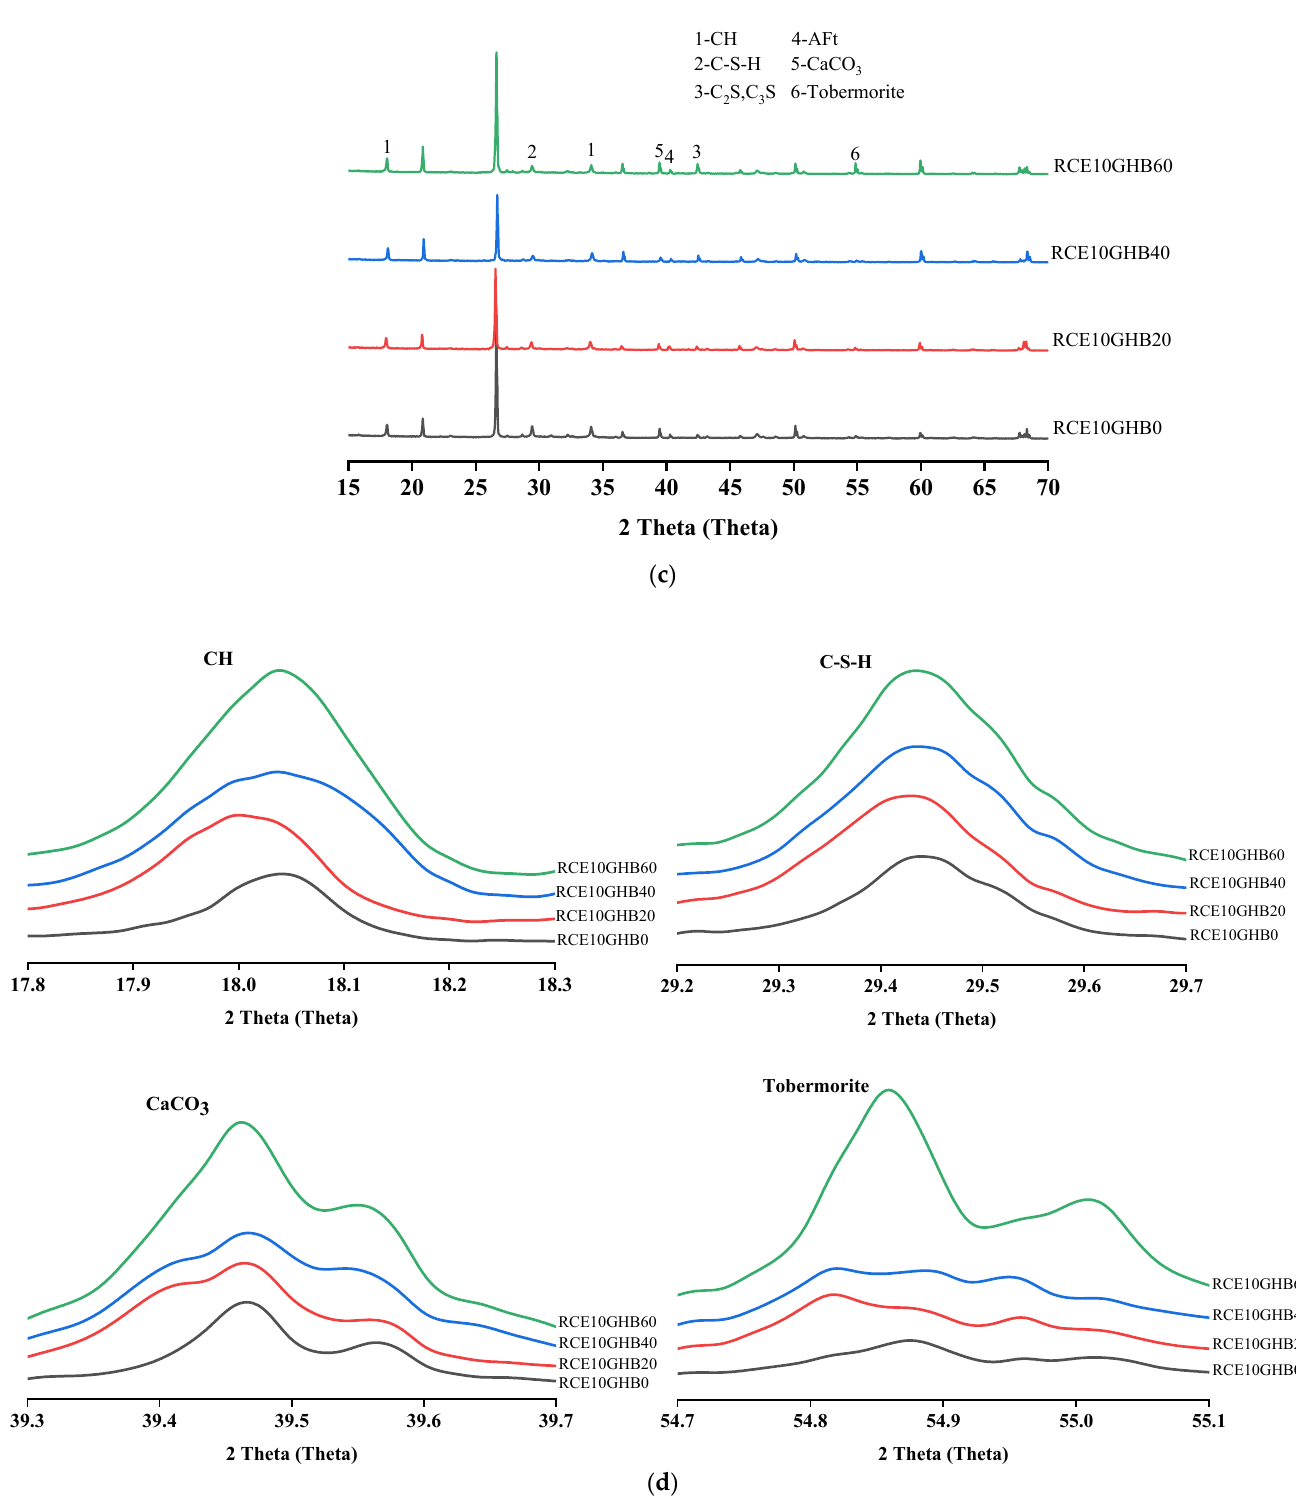
Figure 12. The experimental results of the crystal composition and hydration products of RTIC based on XRD. ( a ) The crystal composition and hydration products of RTIC (RCE0GHB0, RCE10GHB0, RCE20GHB0, RCE30GHB0); ( b ) CH, C-S-H, CaCO 3 , Tobermorite (RCE0GHB0, RCE10GHB0, RCE20GHB0, RCE30GHB0); ( c ) the crystal composition and hydration products of RTIC (RCE10GHB0, RCE10GHB20, RCE10GHB40, RCE10GHB60); ( d ) CH, C-S-H, CaCO 3 , Tobermorite (RCE10GHB0, RCE10GHB20, RCE10GHB40, RCE10GHB60).